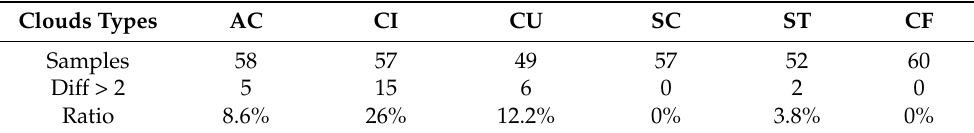
Table 2. Consistency of infrared and visible cloud fractions for different cloud